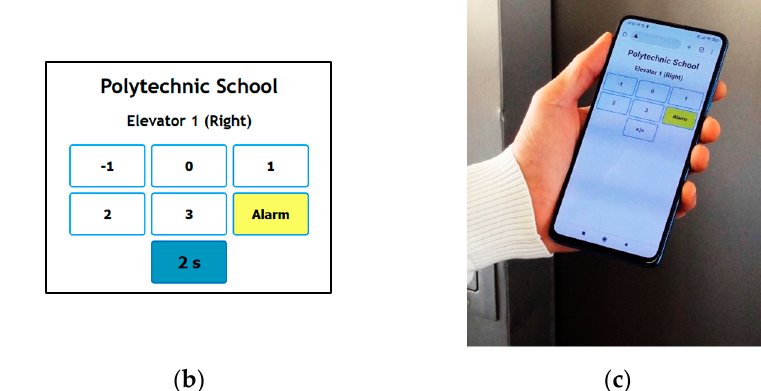
Figure 9. Layout of the web interface of the IoT device: ( a ) user view with all buttons inactive; ( b ) user view after pressing the “open door button”, showing 2 s of remaining time until automatic door closure; ( c ) smartphone user view of the web interface.